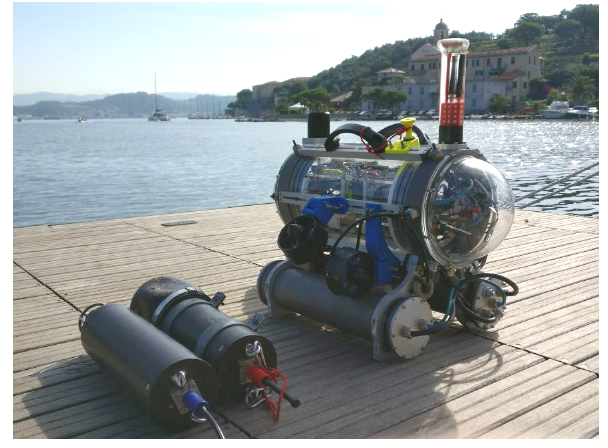
Figure 2. FeelHippo AUV.